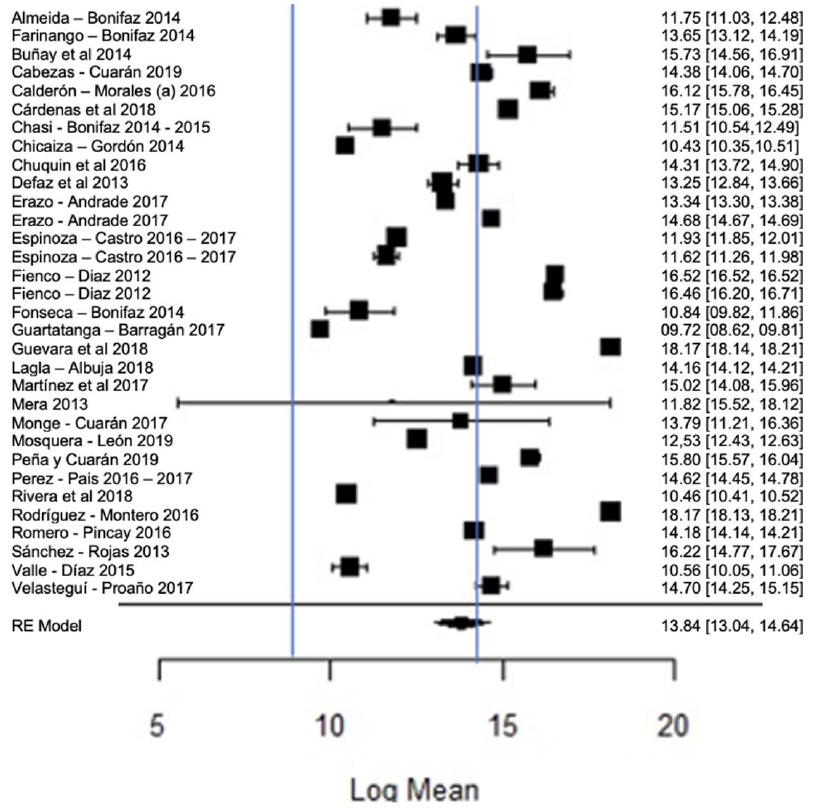
Figure 12. Forest plot of the bacterial count [14,23 – 29,33,35,39,47,52 – 54,56,58,61,63,64,66 –